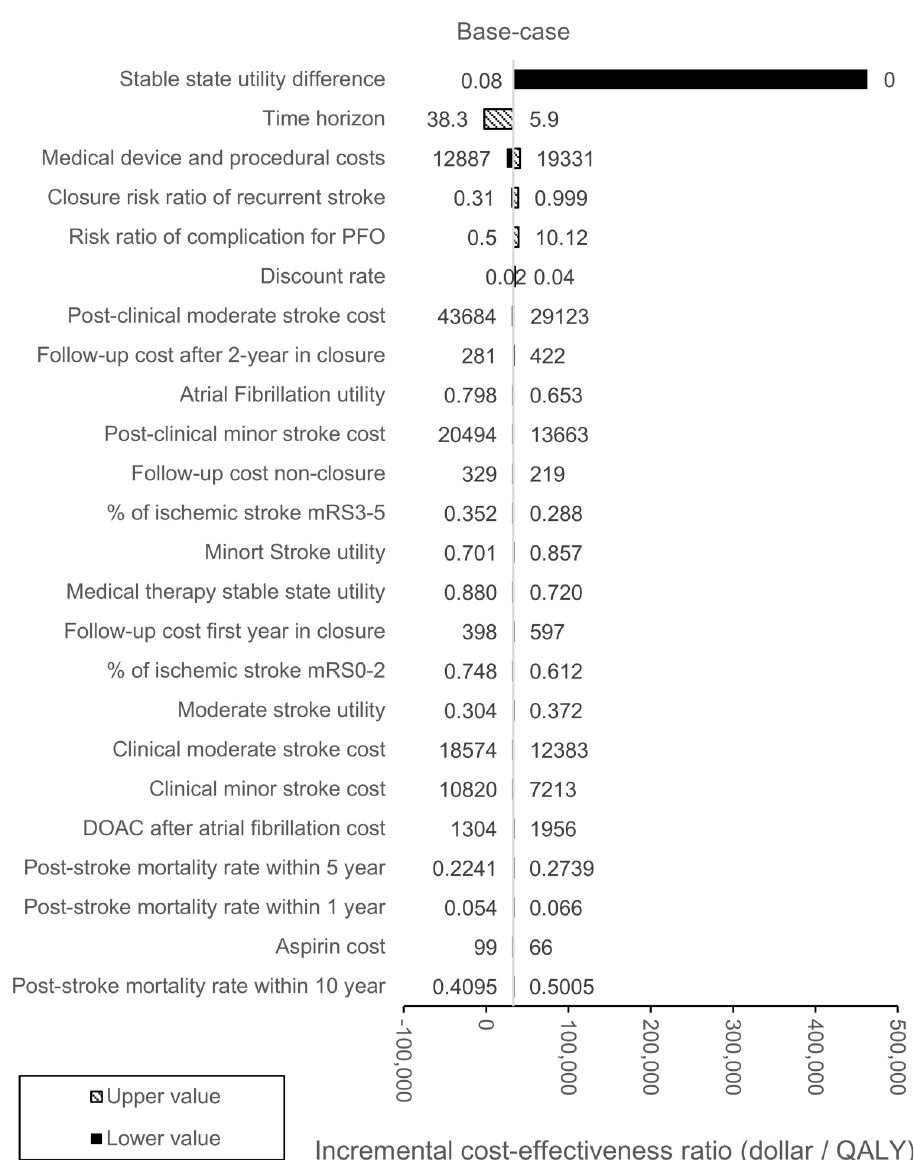
Fig 3. One-way sensitivity analysis of PFO closure VS medical therapy. The impact of parameter variation using a willingness-to-pay threshold of $50,000/QALY. The hatched bars and black bars show the upper (high estimate) and lower values of the parameter, respectively. Bars are aligned in order of impact from largest to smallest. Abbreviations. PFO, patent foramen ovale; mRS, modified Rankin Scale; DOAC, novel direct oral